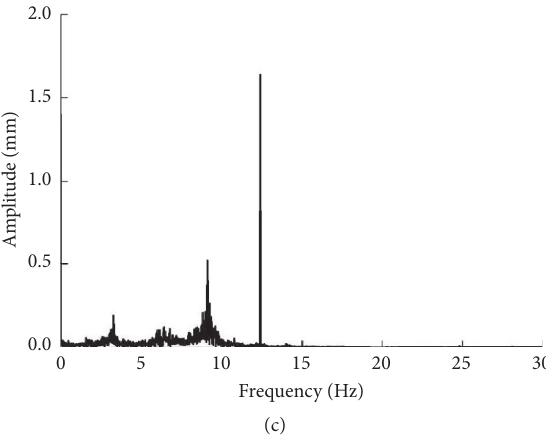
Figure 20: Chaotic motion of the system is obtained for the external excitation frequency Ω � 12 . 4 Hz: (a) waveform; (b) phase portrait; (c) amplitude spectrum.